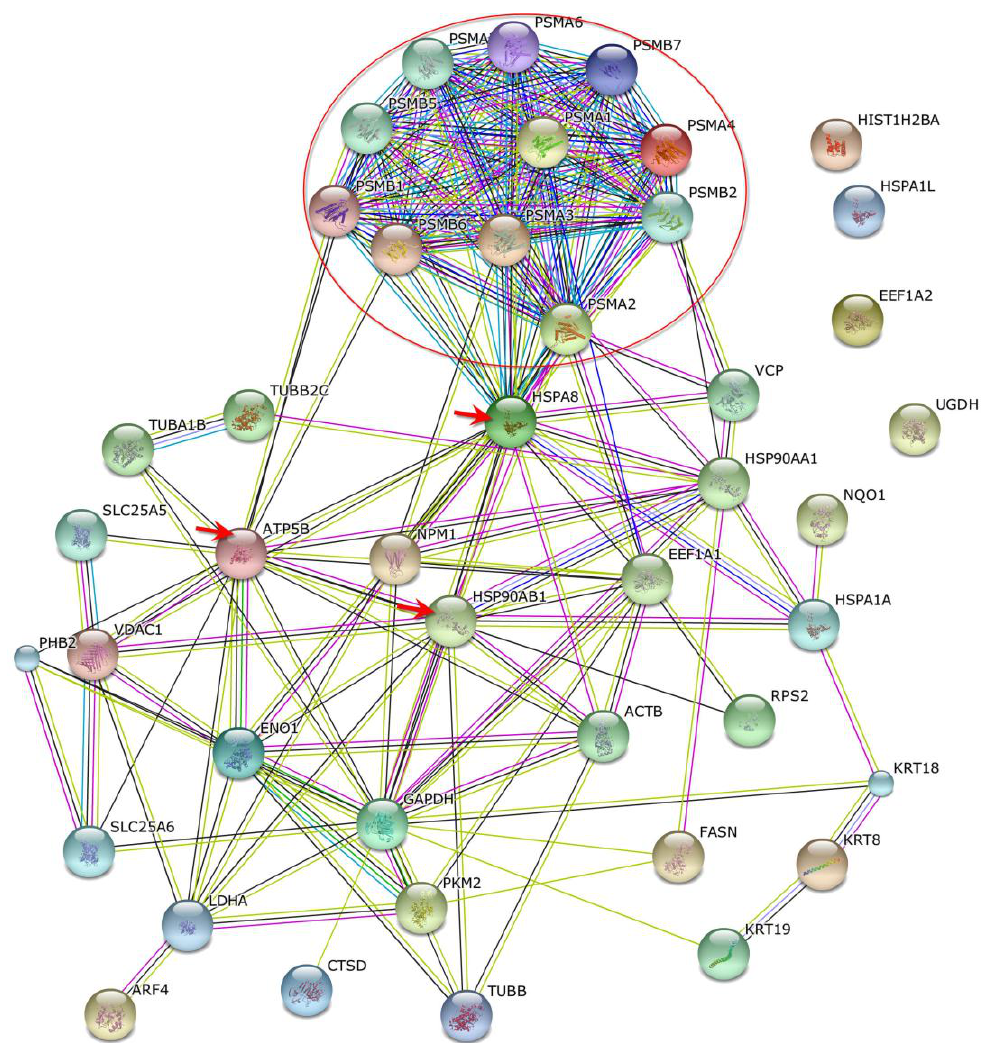
Figure 5. STRING protein–protein interactions between phthalic acid-binding proteins in MCF-7 cells. Red circles containing proteasome subunit proteins and the three red arrows indicate heat shock cognate 71-kDa protein, heat shock protein HSP 90-beta, and ATP synthase subunit